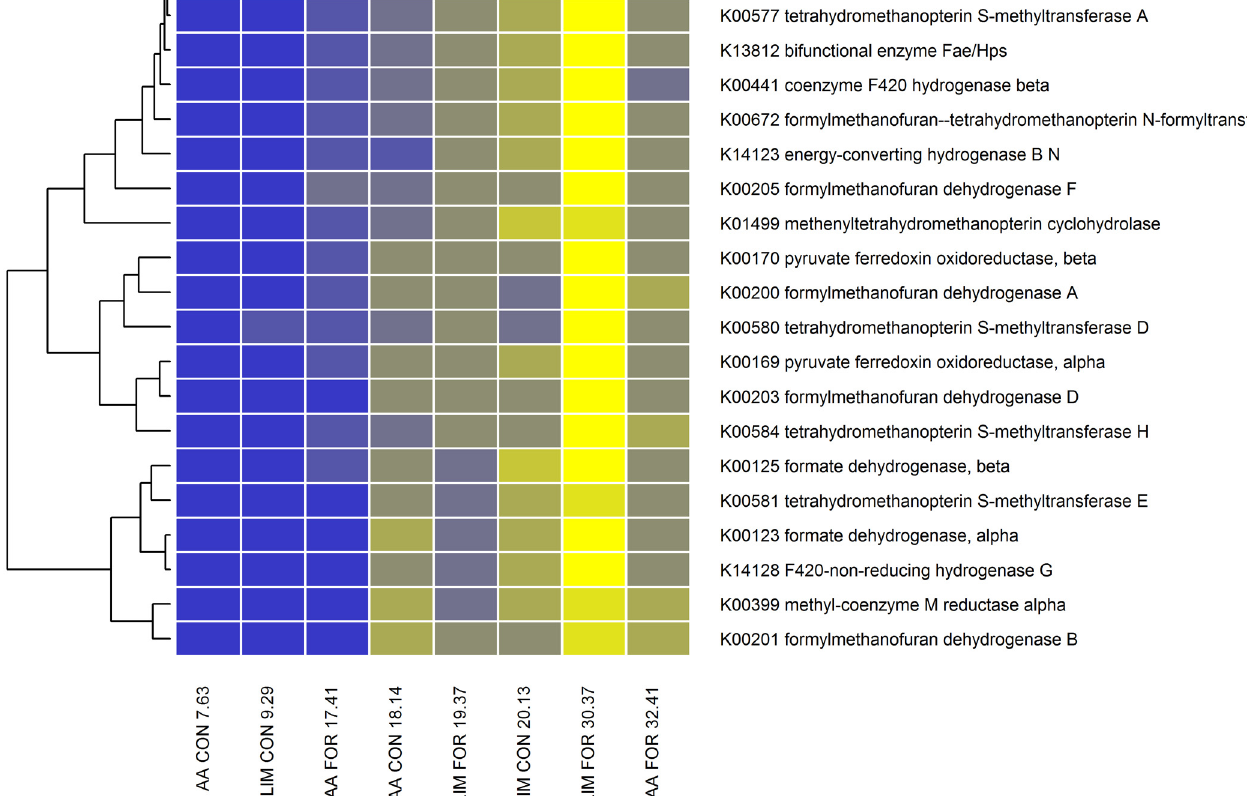
Fig 4. Heatmap of the relative abundance of microbial genes associated with methane emissions as identified in the partial least squares analysis. The relative abundance of microbial genes (blue = low to yellow = high) changed depending on methane emissions (g/kg DMI) for the animals selected for low and high methane emissions within breed type and diet. The labels on the horizontal axis indicate the crossbred breed type (AA = Aberdeen Angus sired, LIM = Limousin sired), diet (CON = concentrate based diet, FOR = forage based diet) and the amount of methane emissions (g/kg DMI).